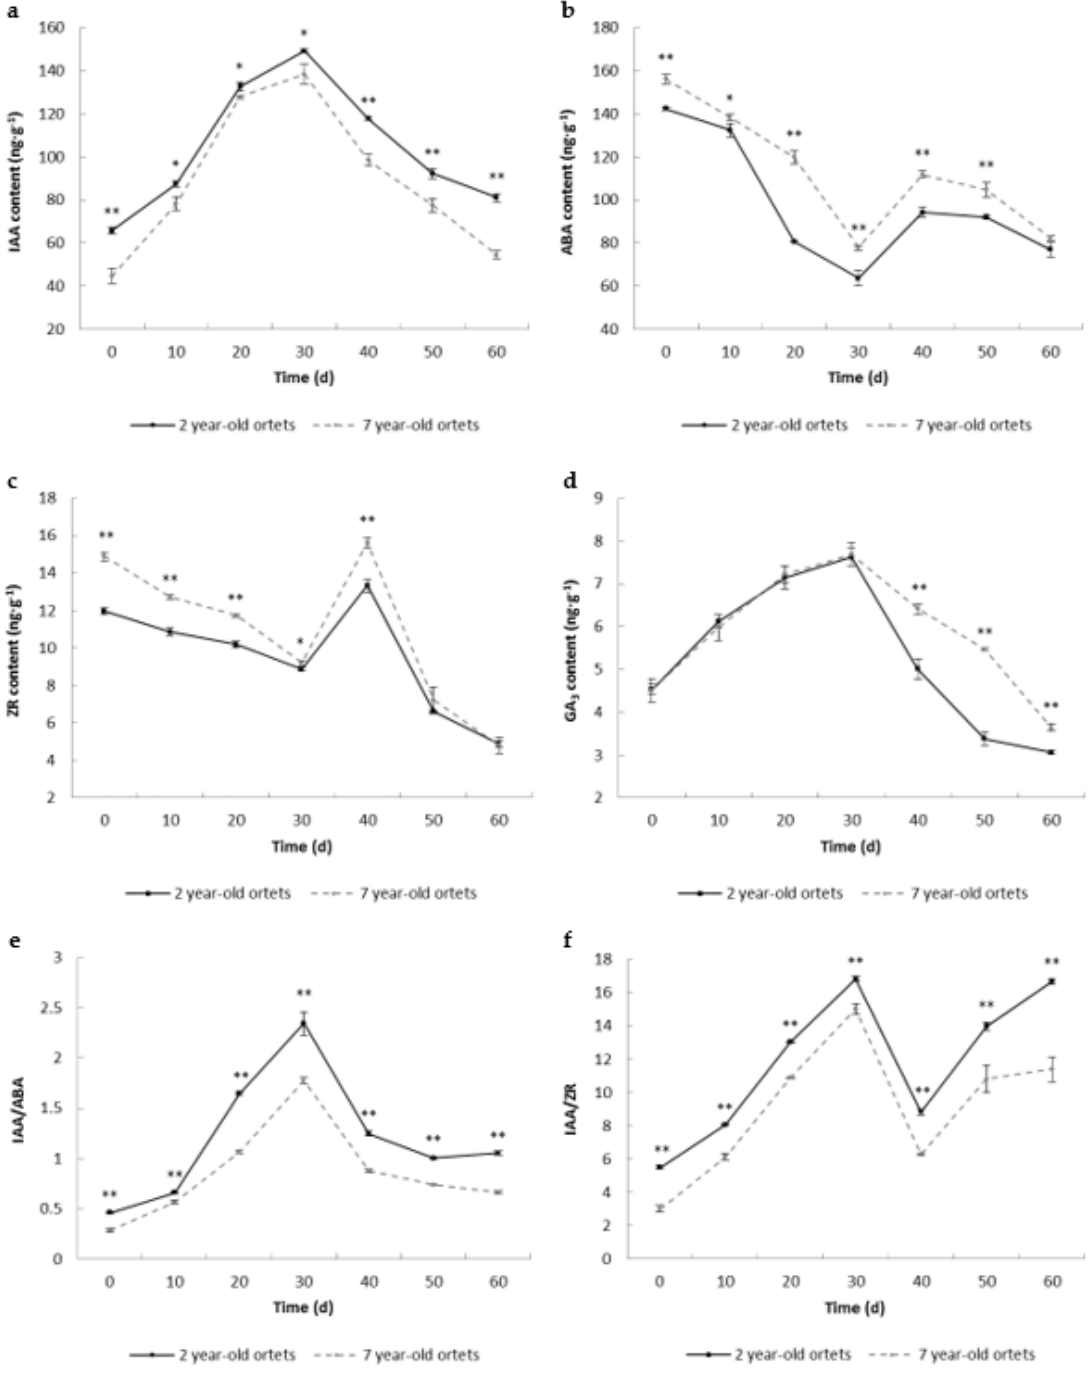
Figure 6. Endogenous hormones of cuttings from 2- and 7-year-old ortets during cultivation. ( a ) 3-indoleacetic acid (IAA); ( b ) abscisic acid (ABA); ( c ) zeatin riboside (ZR); ( d ) gibberellin (GA 3 ); ( e ) IAA/ABA; ( f ) IAA/ZR.